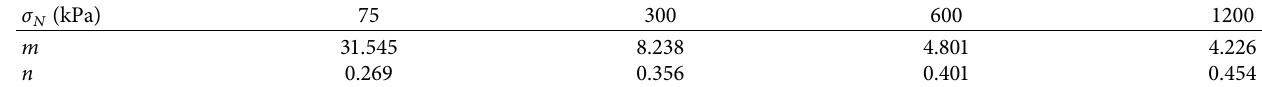
Table 2: The calculated values of the Weibull parameters m and n .